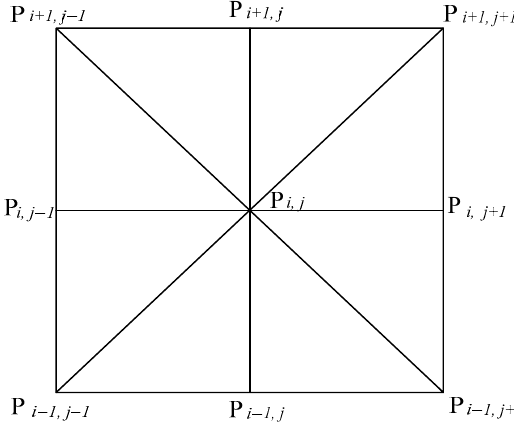
at the edge location.